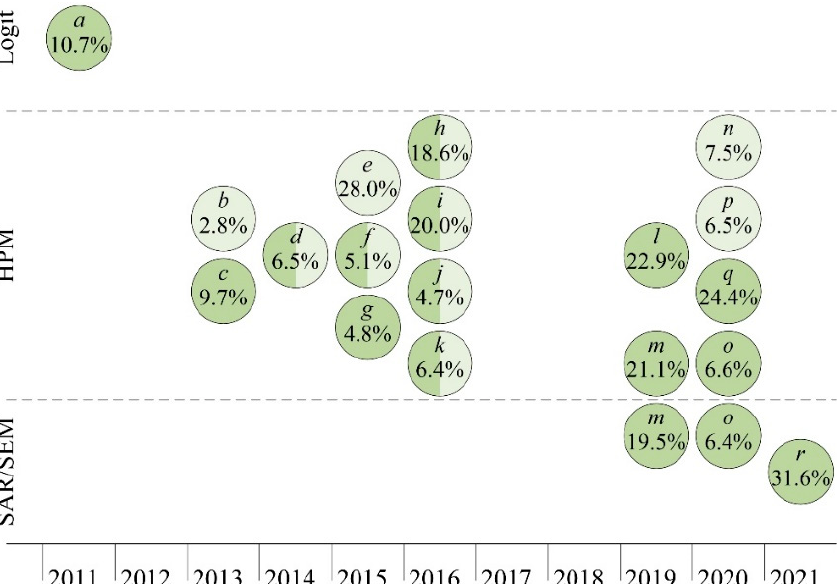
Figure 1. Timeline of studies on the market effect of Energy Performance Certificates (Logit: logistic regression; HPM: Hedonic price model; SAR/SEM: Spatial autoregressive and spatial error models; the reference energy rating band is D unless otherwise stated; percentages are the price premium for the energy rating bands A (dark green) or B (light green); percentages are corrected according to [69] when appropriate; a : [70]; b : [71]; c : [72]; d : [73]; e : [74]; f : [75]; g : [76]; h : [77]; i : [78]; j : [79]; k : [80]; l : [81]; m : [82]; n : [67]; o : [83] with G as the reference energy rating band; p : [84]; q : [85]; r : [19]).